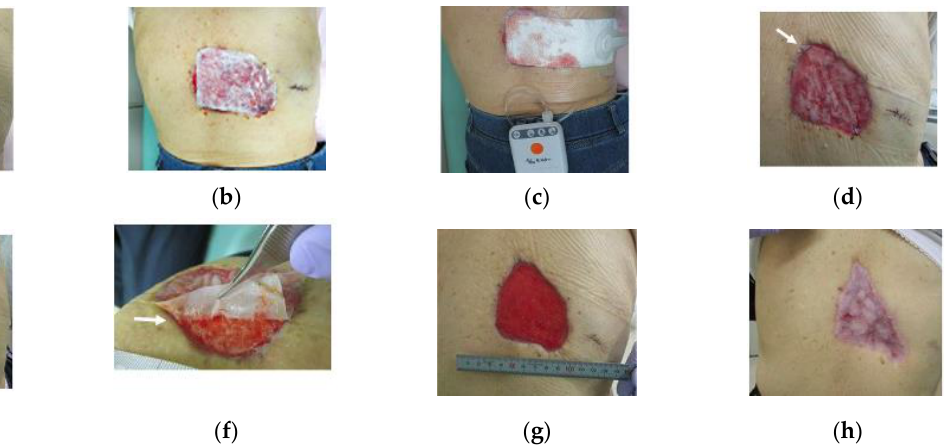
Figure 1. Case: 72-year-old female patient with a post-surgical skin ulcer after a tumor resection on the back. ( a ) Preoperative observation: ulcer formation was 80 × 85 mm in size. Donor sample was harvested from the back near the skin defect, excised in a spindle shape with the longer diameter measuring 15 mm. ( b ) Immediately after application of artificial dermis: micrograft-infused artificial dermis was applied to the wound. ( c ) NPWT: Immediately after the operation, NPWT was started using PICO 7 ® . ( d ) Postoperative day 3: At the time of transplant, the section (shown with arrow) of the artificial dermis was adjacent to the wound but became unnecessary due to ulcer contraction and was collected for evaluation. ( e ) Postoperative day 7: The artificial dermis was still close to the wound on postoperative day 3, but this section (shown with arrow) became unnecessary due to ulcer contraction and was collected for evaluation. ( f ) Postoperative day 7: The silicone film of the artificial dermis was removed. Almost all of the collagen sponge layer adhered to the ulcer surface, and the silicone film was easily removed. ( g ) Overall contraction of the ulcer was achieved with favorable granulation. ( h ) Epithelialization of the ulcer.